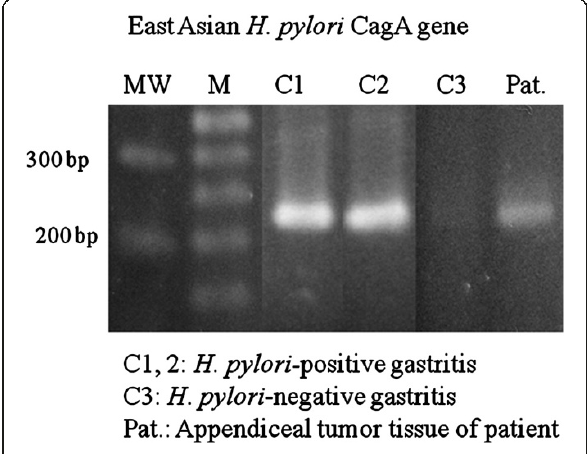
Figure 4 Detection of the CagA gene of the East Asian type H. pylori . The CagA gene (222 bp clonal bands) detected in DNA extracted from tissue specimens using primer set CAGJF/CAGTR. C1 and C2: H. pylori - positive gastritis cases. C3: H. pylori - negative gastritis case. Pat.: patient